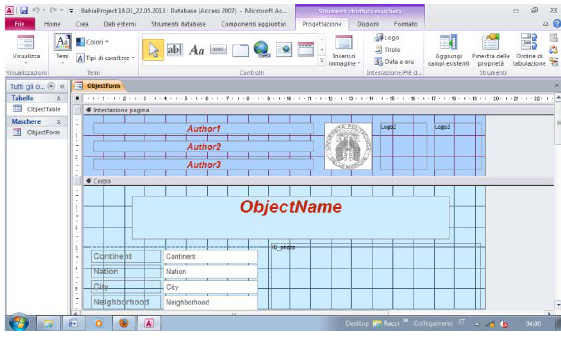
Figure 7. The Object Form structure